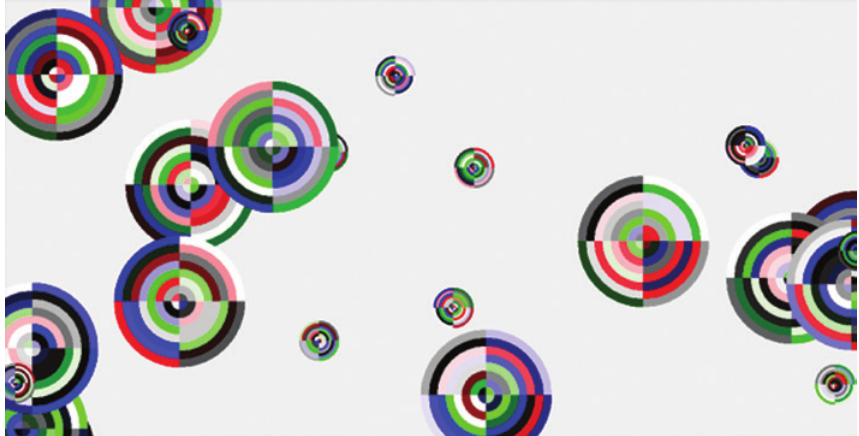
Figure 10: Best Individual from Experiment 16.